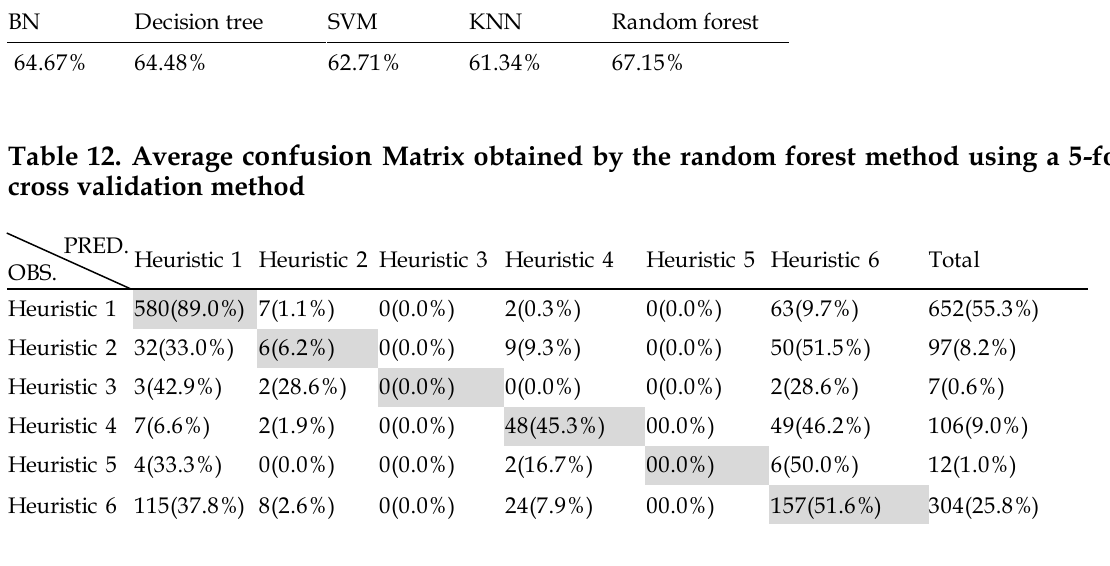
Table 13. Variable importance measures obtained by the random forest